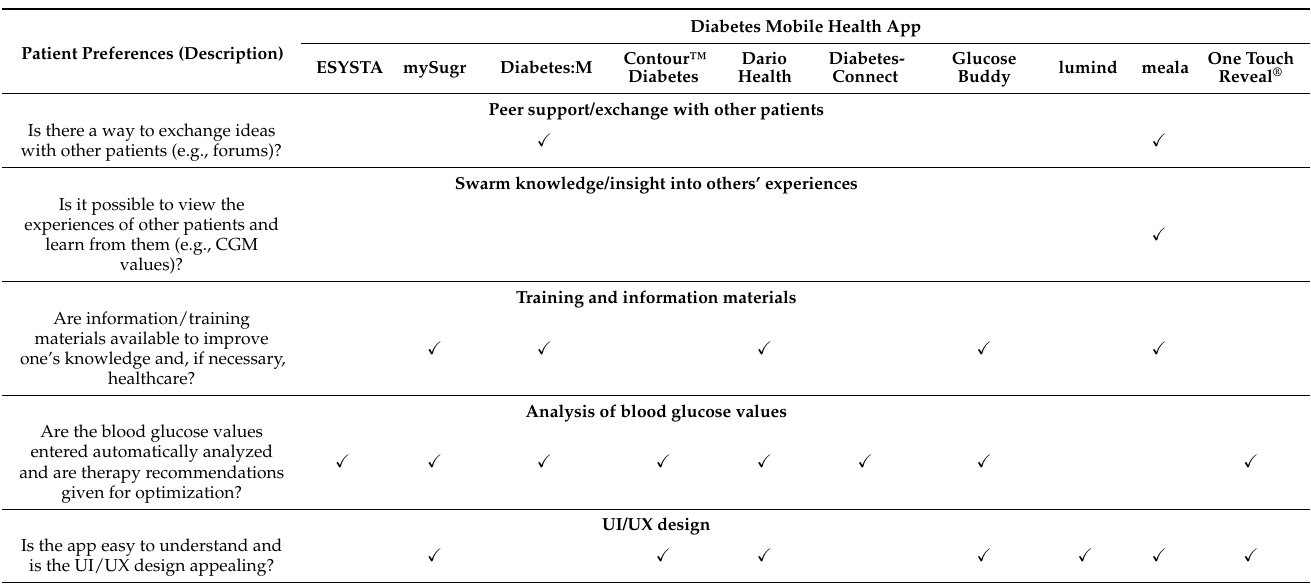
Table 4. Patients’ preferences for active engagement with diabetes